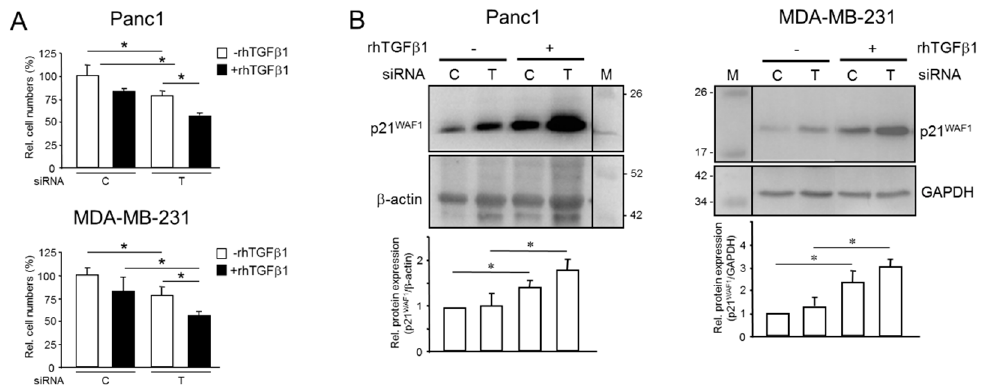
Figure 4. Effect of silencing TGFB1 on rhTGF β 1-induced growth arrest in pancreatic and breast cancer cells with aTGF β production. ( A ) Panc1 or MDA-MB-231 cells were transiently transfected with 50 nM of either control (C) siRNA or TGFB1 (T) siRNA and subsequently subjected to treatment with rhTGF β 1 (5 ng/mL) for 50 h. Cells were trypsinized and counted. Data (cell numbers) shown are representative of three assays, with non-rhTGF β -treated control transfectants set arbitrarily at 100 (mean ± SD, n = 3). ( B ) Immunoblot analysis of p21 WAF1 in Panc1 or MDA-MB-231 cells transfected as outlined in ( A ) but treated with rhTGF β 1 for 24 h. The graphs underneath the blots show results from densitometry-based quantification of band intensities (mean ± SD, n = 3). Successful knockdown of TGFB1 in ( A , B ) was verified by ELISA of secreted TGF β 1. The asterisks ( ∗ ) indicate significance ( p <